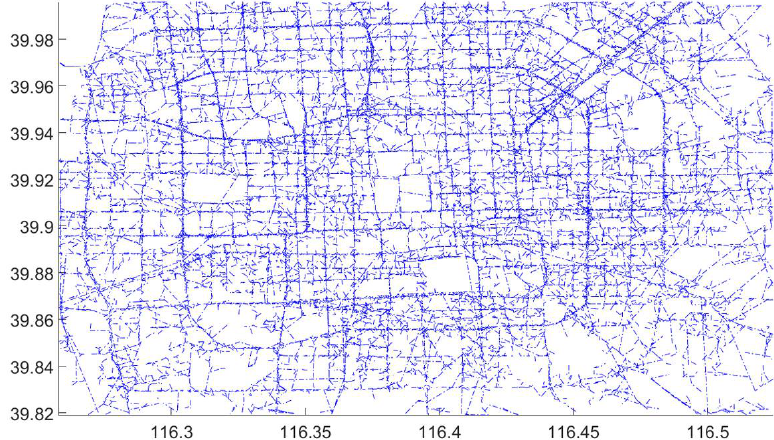
Figure 3. Line segments are produced in term of taxi GPS data points (illustration in Figure 2) using the angle-based approach.